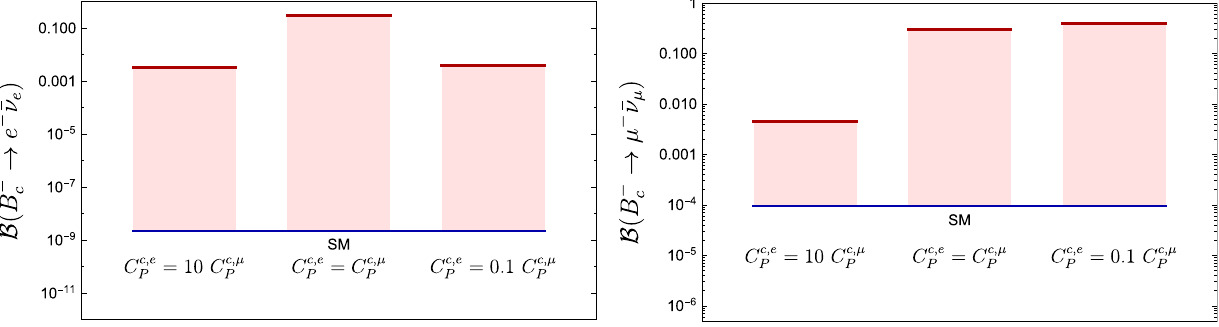
Fig. 20 Possible enhancements of B ( B c → e − ¯ ν e ) (left) and B ( B c → μ − ¯ ν μ ) (right) for the different NP scenarios correlating the Wilson coefficients of electrons and